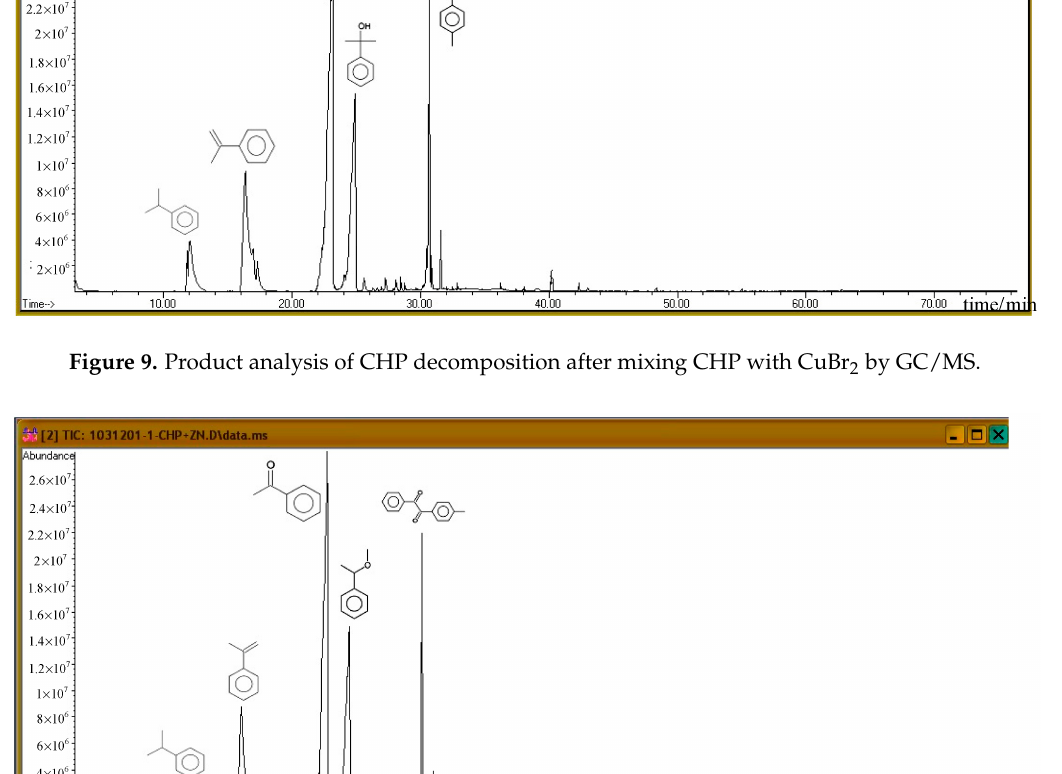
Figure 10. Product analysis of CHP decomposition after mixing CHP with FeBr 2 by GC/MS.